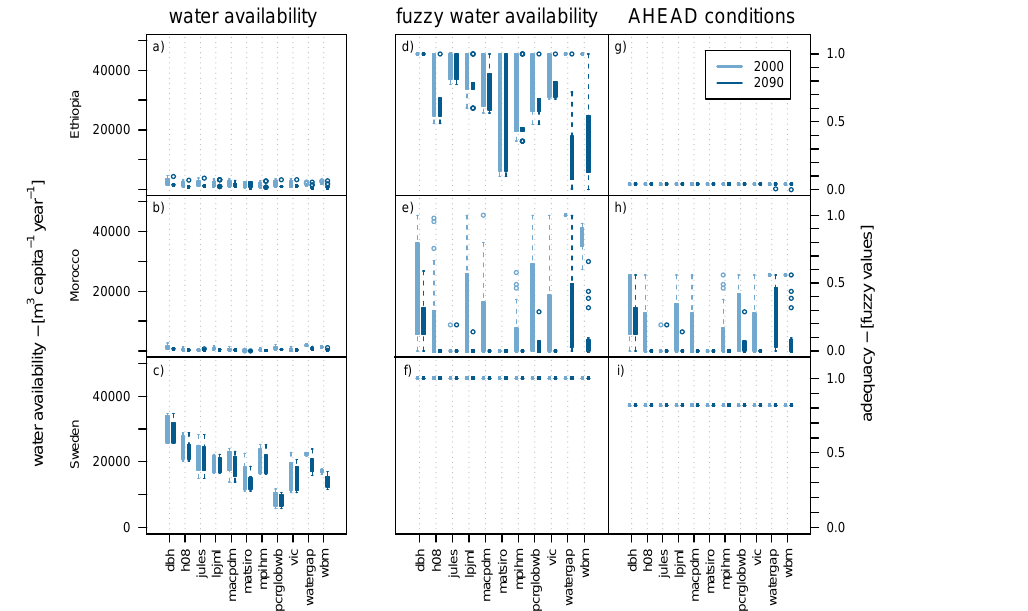
Figure 4. Examples of input data and fuzzified values/results for the examples Ethiopia, Morocco and Sweden. Left panels: per capita water availability; middle panels: fuzzified water data; and right panels: AHEAD results. Right axis labels and units (adequacy – fuzzy values) apply to middle and right panels. Results of the individual impact models are plotted from left to right within panels, showing the result range for all GCMs and RCPs for each time